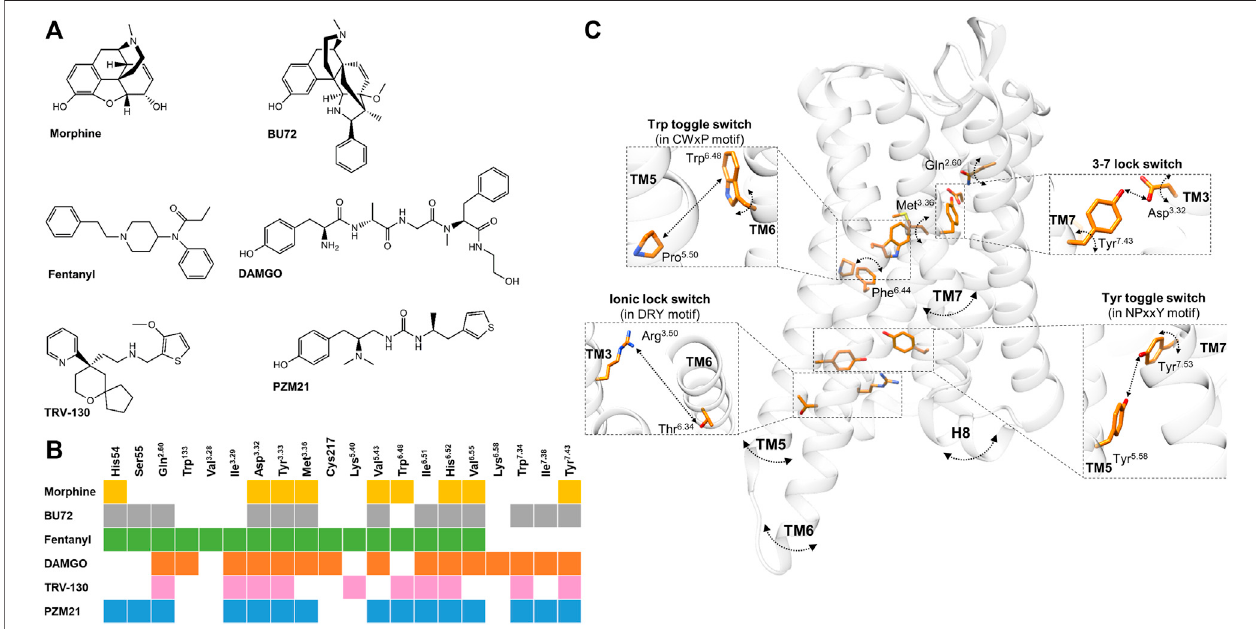
FIGURE1|(A) ChemicalstructuresofµOR-selectiveagonistsdiscussedinthereview. (B) TheknownµORresidualcontactsoftheindicatedagonists.Theoriginal conceptofthe fi gure wasbasedonFigure 4ofPodlewskaand co-workers ’ study(Podlewskaet al.,2020)and extended byotherdata(Huanget al.,2015;Chenget al., 2018;Koehlet al.,2018;Ma fi et al.,2020;Ricarte et al.,2021). (C) Individualmovements ofthehighlightedresidues, molecularswitches, and TMdomains based onthe data reviewed in the 3rd and 4th sections.. Participating residues are indicated in orange, arched arrows indicate the presence of spatial movements (but not the direction itself), while straight arrows depict the presence of altered distance between two residues. The corresponding agonists inducing these movements and alterations are not indicated for clarity; for details see in the 3rd and 4th sections. µOR is transparent for better visibility. The fi gure was constructed with UCSF